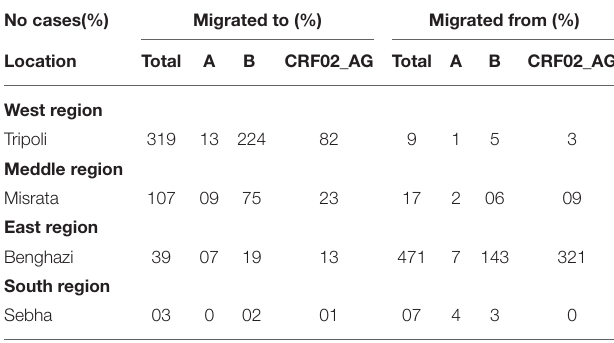
TABLE 3 | Inter-location series of HIV-1 strains in Libya during the armed conflict of 2011-2010. No